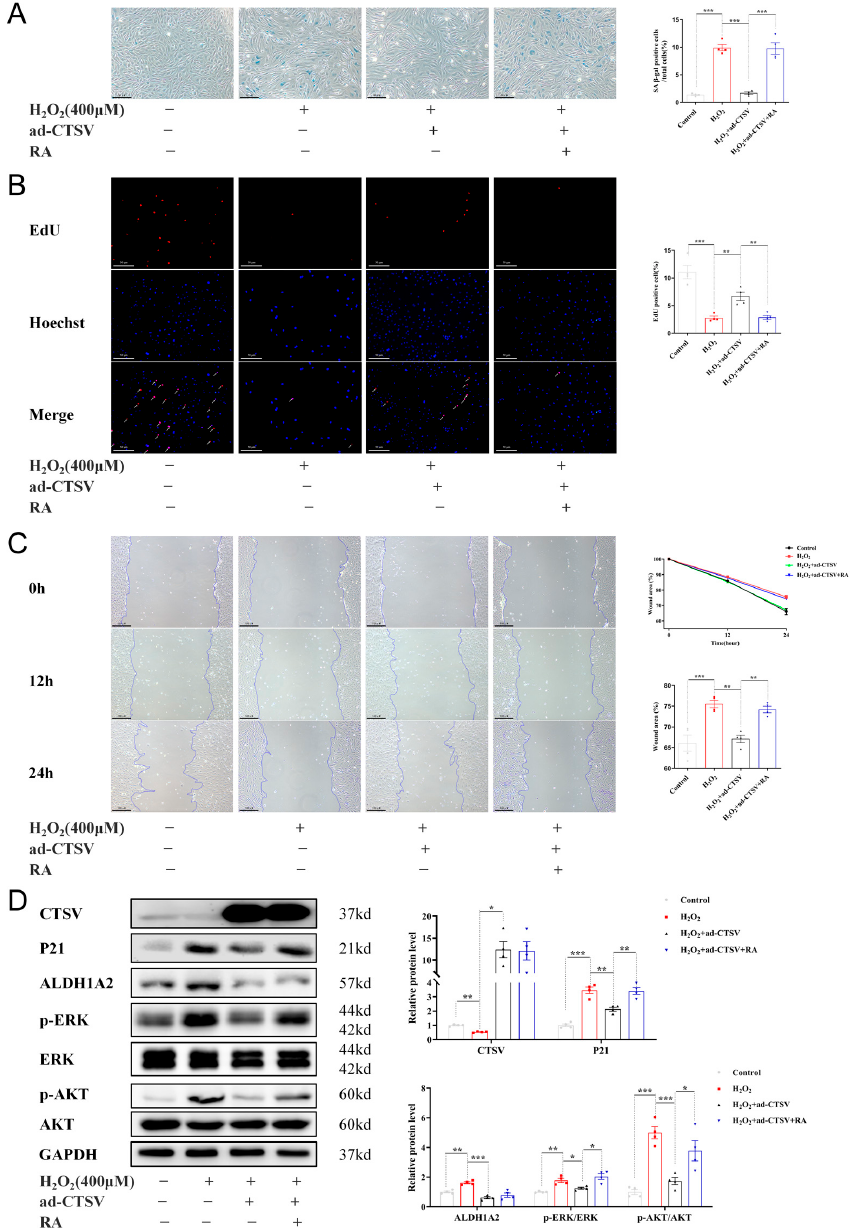
Figure 5. CTSV regulates cellular senescence through ALDH1A2-AKT/ERK1/2-p21 pathway. ( A ) HUVECs were treated with ad-negative control (NC) or ad-CTSV (MOI = 10) for 8 h and simulated with 400 μ M H 2 O 2 and 1 μ M RA for 24 h after incubated in complete growth medium for 40 h. SA- β -gal activity was analyzed (blue staining for the senescent cells, scale bar = 50 μ m, n = 4). ( B ) EdU assay of the cell proliferation ability in HUVECs treated with H 2 O 2 , RA, and ad-CTSV (red staining for the EdU, blue staining for Hoechst, scale bar = 50 μ m, n = 4). ( C ) Representative image of the wound healing assay and the quantification of wound area in HUVECs (scale bar = 100 μ m, n = 4). ( D ) Western blot of CTSV, P21, ALDH1A2, p-ERK1/2, ERK1/2, p-AKT, and AKT in HUVECs treated with H 2 O 2 , RA, and ad-CTSV ( n = 4). Data are presented as mean ± SEM. One-way ANOVA test was used. * p < 0.05, ** p < 0.01, *** p < 0.001.